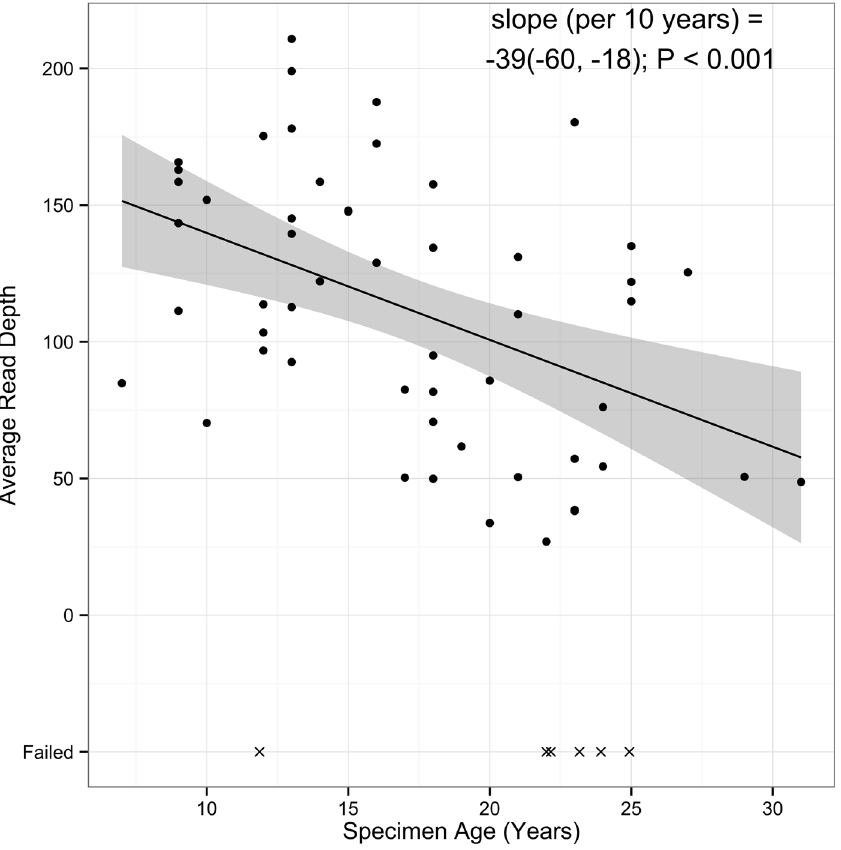
Fig 4. Association between specimen storage time and average read depth. The solid line indicates the estimated linear relationship between age and average read depth. The shaded area denoted pointwise 95% confidence intervals of the conditional mean. Cases successful through the entire WES workflow (DNA extraction through WES sequencing) are denoted as circles (N = 53); unsuccessful cases are denoted as X ’ s (N = 6). Failed assays were not used to estimate the linear trend.